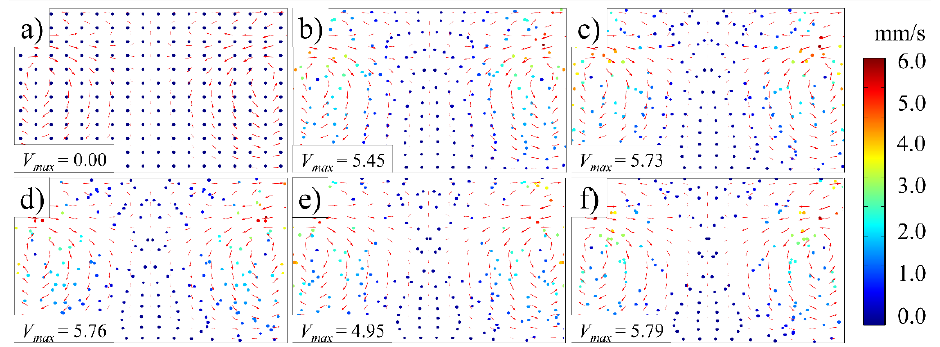
Figure 5. Trajectory of fluorescent particles (ultrasonic frequency, 20 kHz; ultrasonic amplitude, 80 μm): ( a ) 0 s; ( b ) 1 s; ( c ) 2 s; ( d ) 3 s; ( e ) 4 s; ( f ) 5 s.